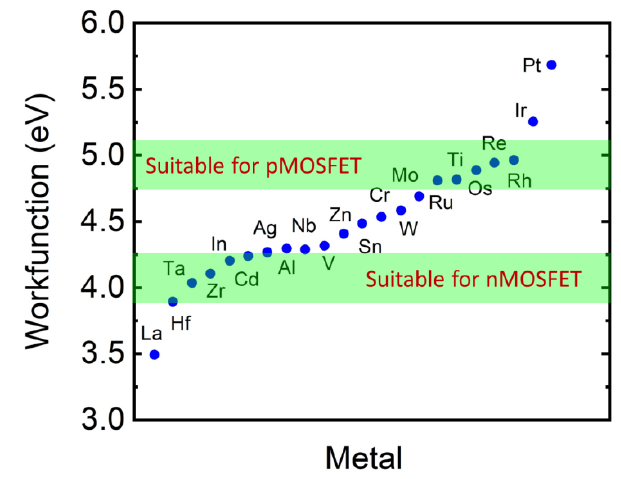
Figure 6. Depletion layer formed in poly-Si. ( a ) schematic of a MOSFET; ( b ) band structure of poly-Si/oxide/semiconductor.